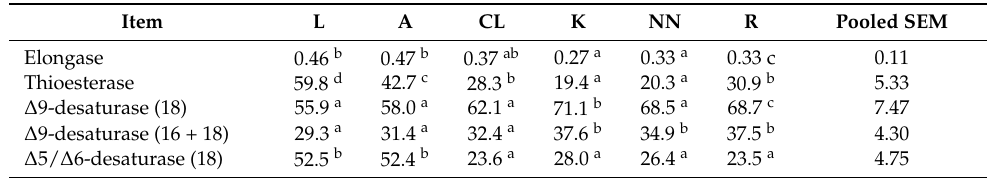
Table 5. Estimated indices of fatty acid metabolism (on the basis of fatty acid composition) in breast muscle of different genotypes. Modified from [25]. Item